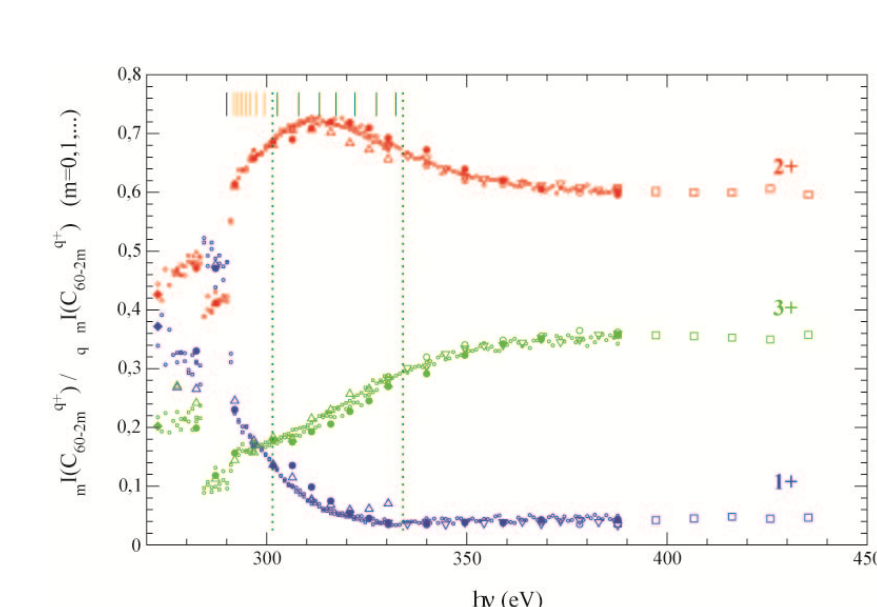
Figure 3 – Contributions of singly, doubly, and triply charged fullerene ions for several photon energies. Different scans are marked by different symbols. The results of the coincident electron spectrum are marked by 'e'. The vertical lines indicate the C(1s) threshold ( ∆ ), electron shake-up levels ( ∆ ), and plasmon excitation energies ( ∆ ) (Leiro et al, 2003, pp.205-213). The high amount of triply charged fullerene can be explained by double Auger and electron shake-off processes, observed in the electron-electron- coincidence map